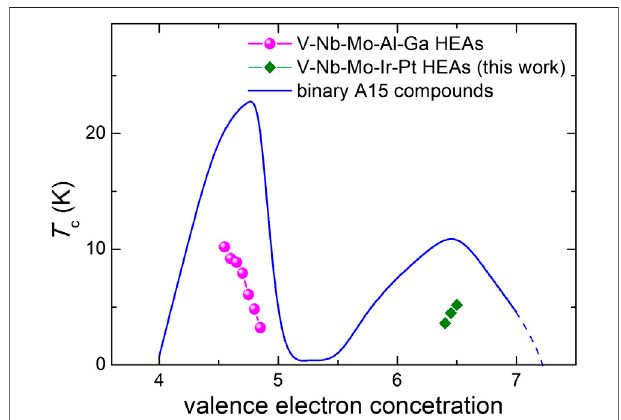
FIGURE 6 | VEC dependence of T c for the A15-type HEA superconductors. The solid line denotes the T c behavior of binary A15